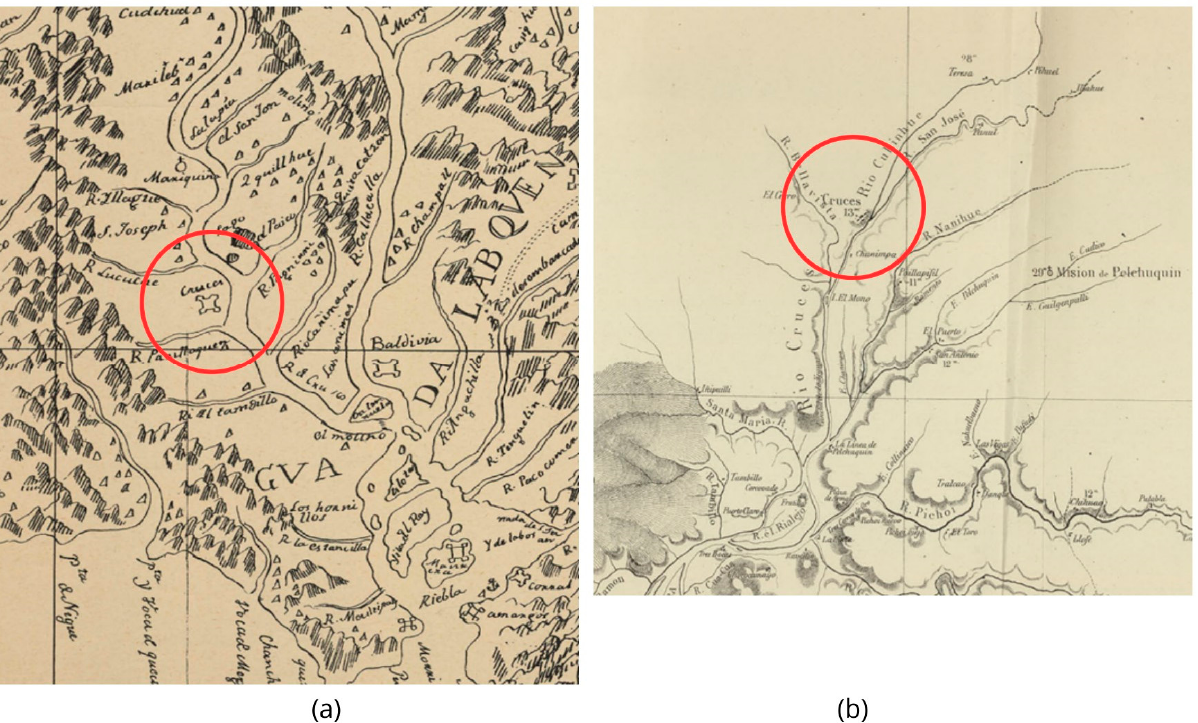
Figure 2. Maps showing the San Luis del Alba or Cruces Fort: ( a ) 18th century map, by Fray Ignacio de León Garabito 1759; ( b ) 19th century map, Vidal Gormáz 1869.